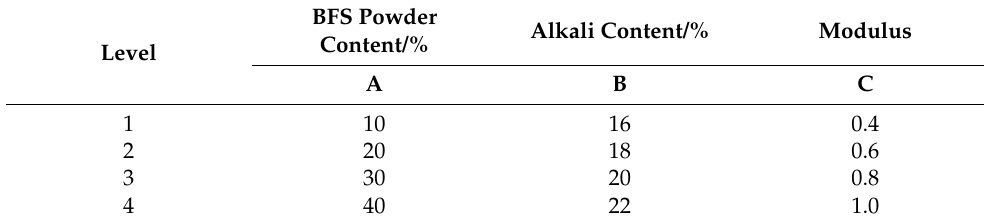
Table 4. Stage I: orthogonal design test. Sample No.